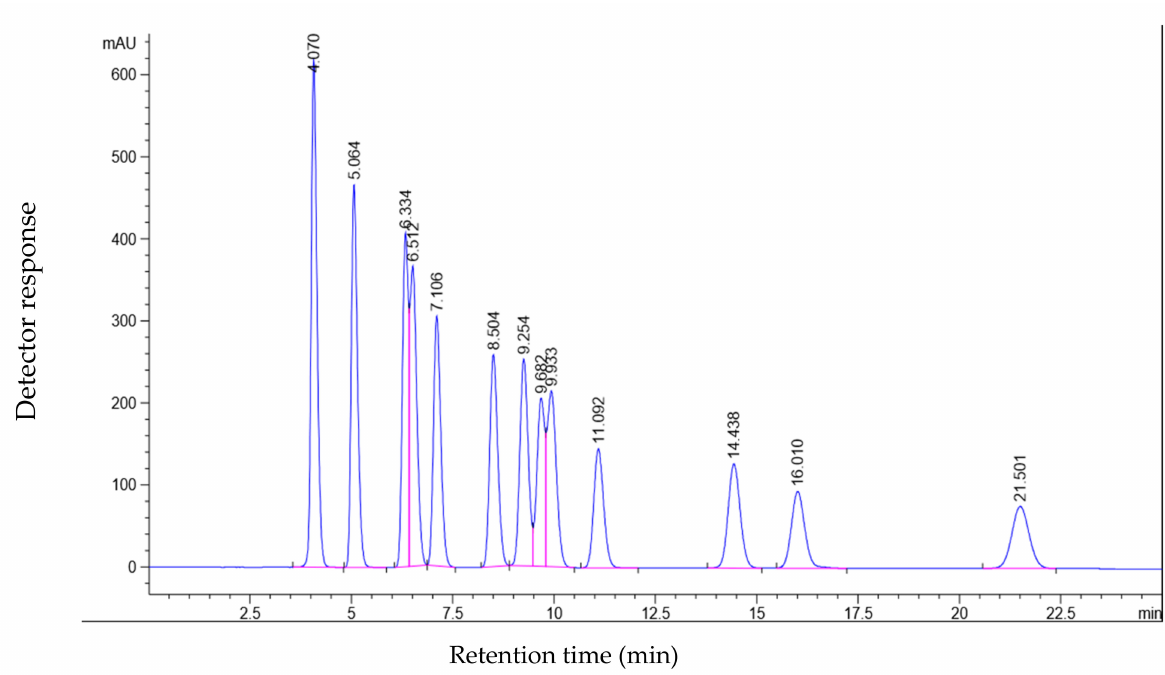
Figure 5. Experimental liquid chromatogram of standard-13.